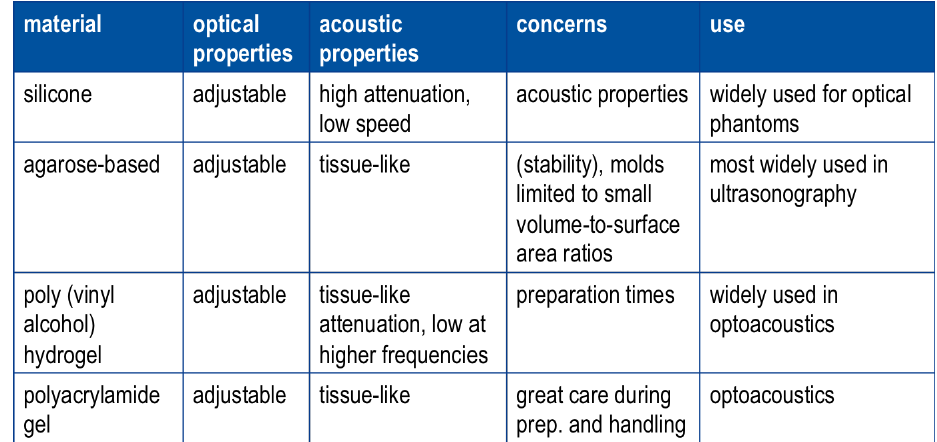
Figure 23. Comparison of possible materials for soft-tissue-like reference samples to be used for both optical and acoustic